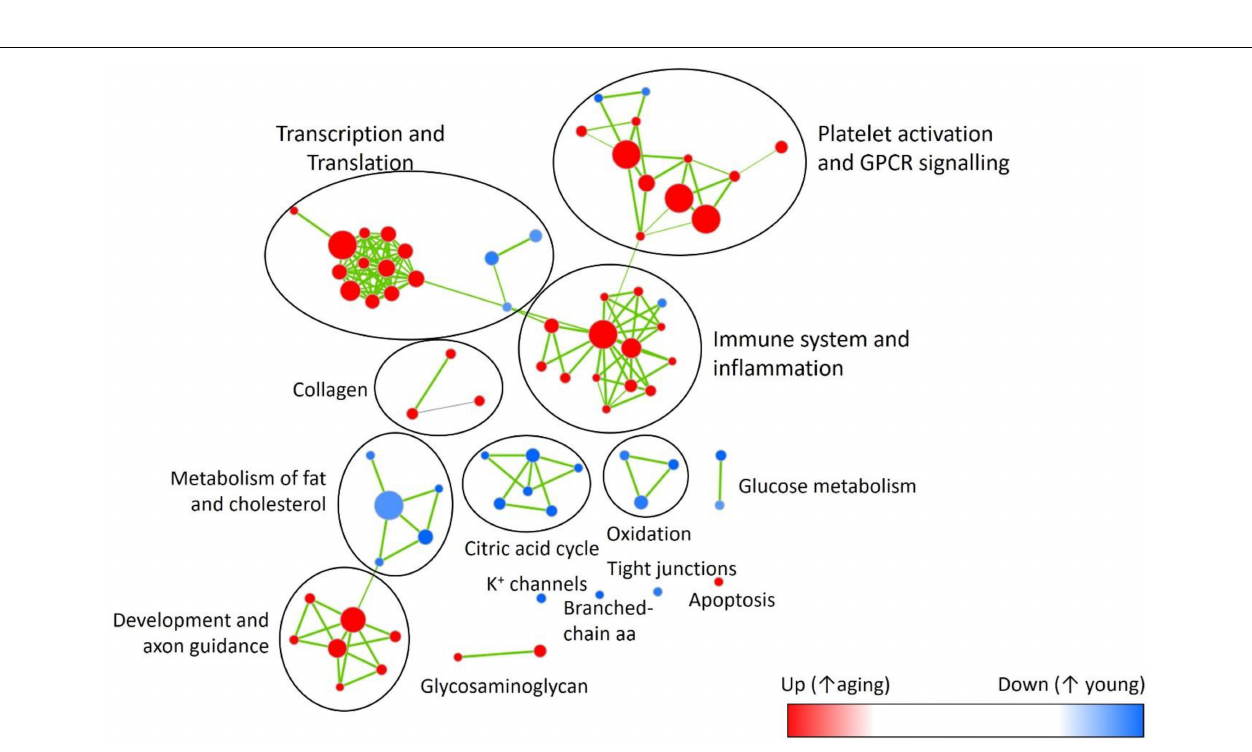
FIGURE 6 | Enrichment map highlighting major pathway up- ( red ) or down-regulated ( blue ) with aging. Showing reactome pathways (Supplementary Table S8) that had false discovery rate < 0.05 in the gene-set enrichment analysis.